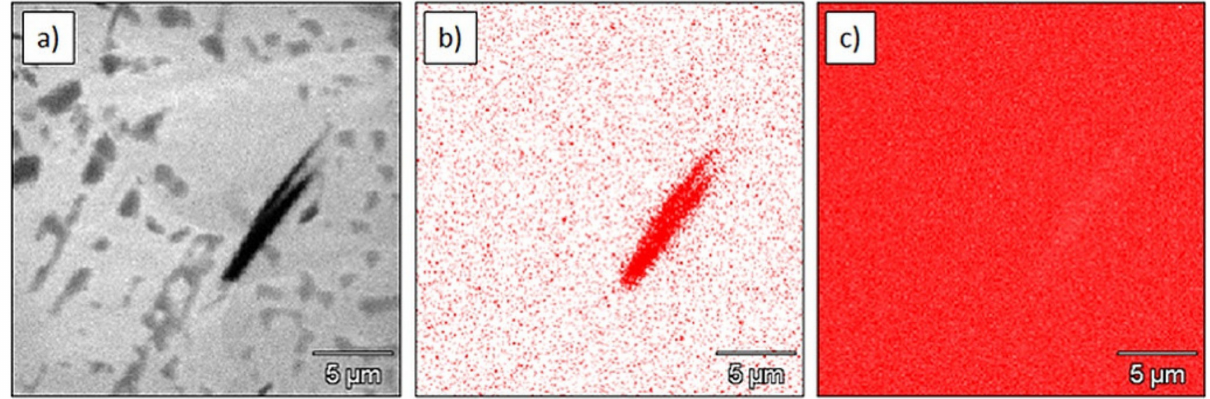
Figure 3. Microstructure and elemental maps of Ti sinter: ( a ) microstructure; ( b ) elemental map of boron (WDS); ( c ) elemental map of titanium (EDS).